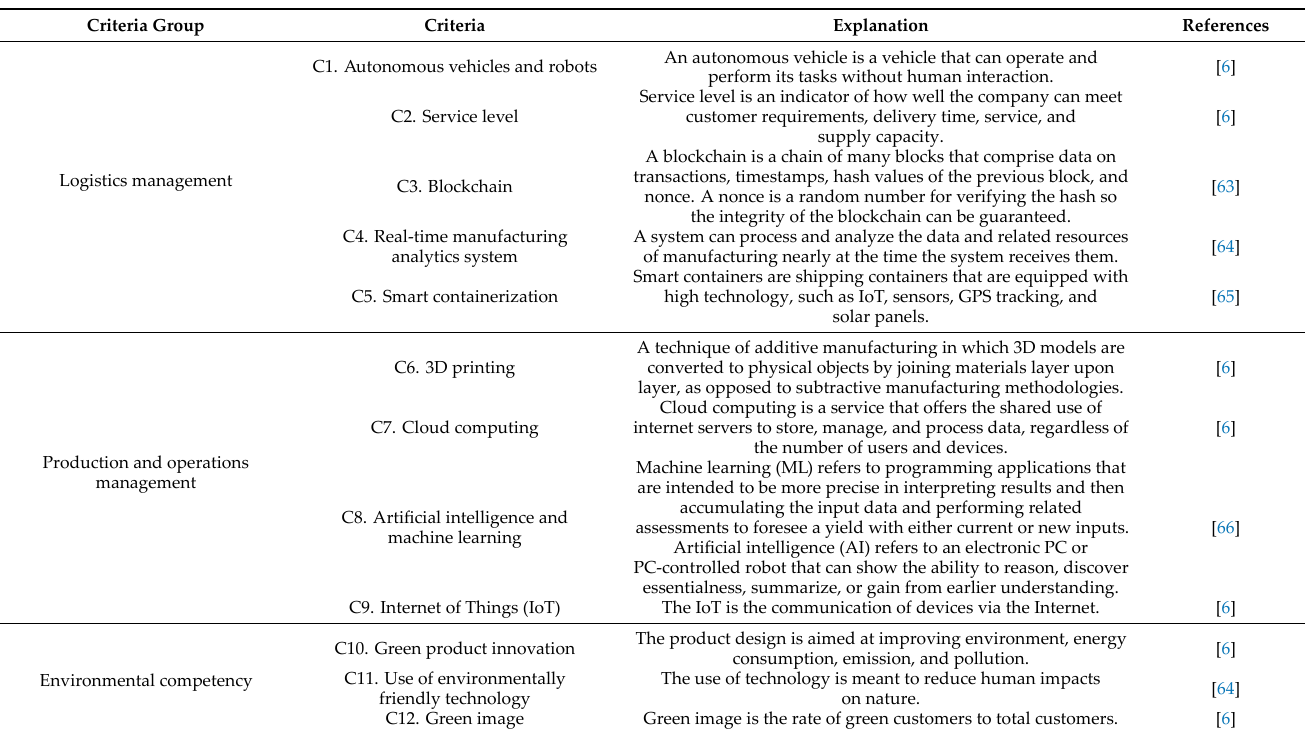
Table 5. Criteria